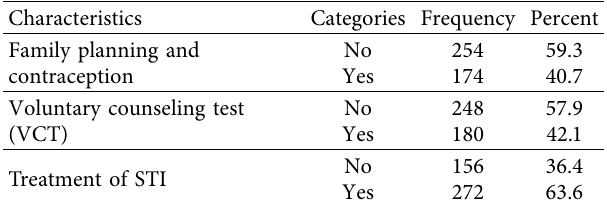
Table 4: Practice of utilization of young-friendly reproductive health services among students of MTU-Tepi campus, 2019 ( n � 428).